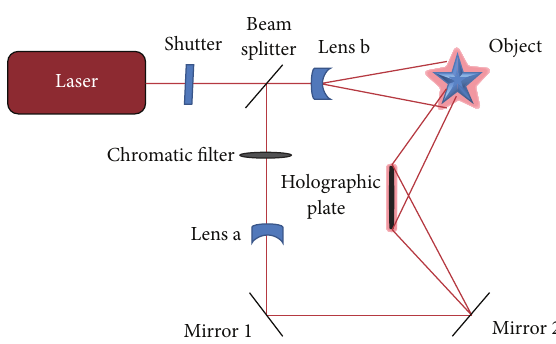
Figure 2: Split-beam setup.